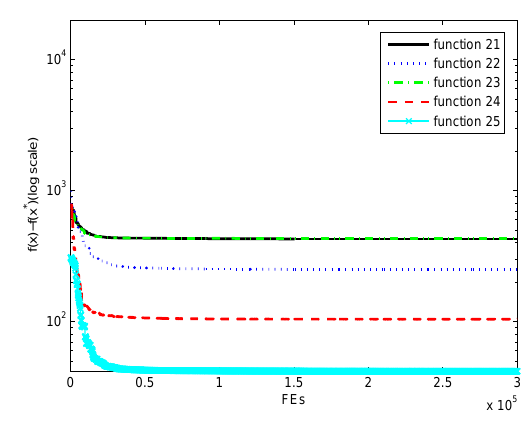
Fig. 4. Convergence Graph for f 16 − f 20 .